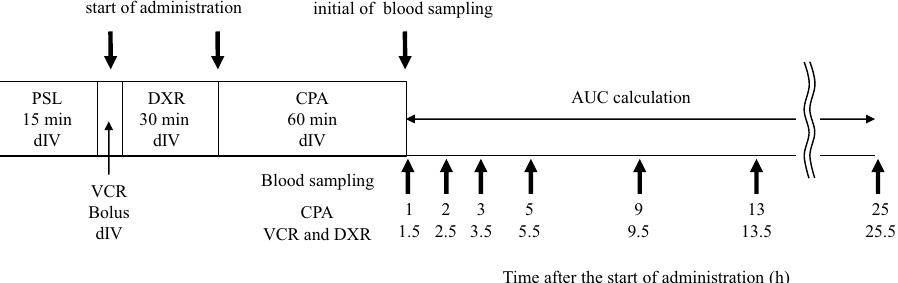
Figure 3. CHOP regimen and blood sampling protocol. AUC, area under the plasma concentration–time curve; CPA, cyclophosphamide; dIV, drip infusion into vein; DXR, doxorubicin; PSL, prednisolone; VCR,